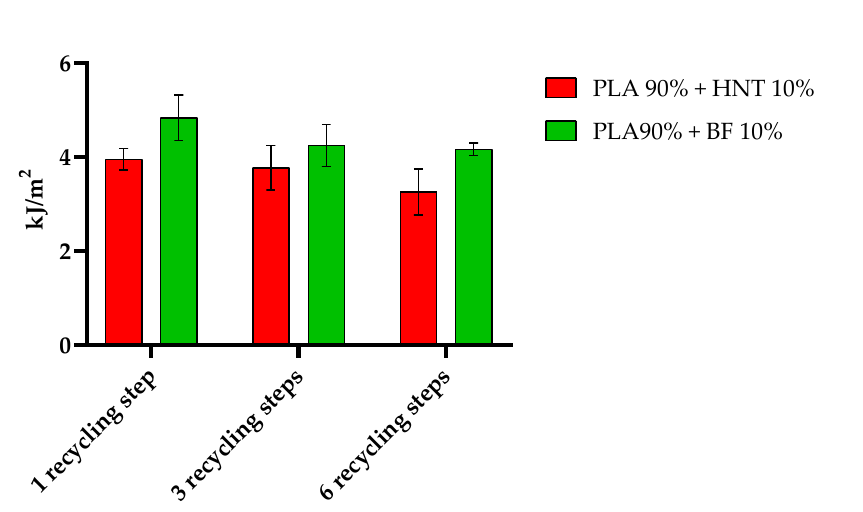
Figure 7. Comparison of the impact strength between PLA/HNT and PLA/BF composites recycled a total of 6 times (n = 6). (red) PLA 90 wt.% and HNT 10 wt.% and (green) PLA 90 wt.% and BF 10 wt.%.